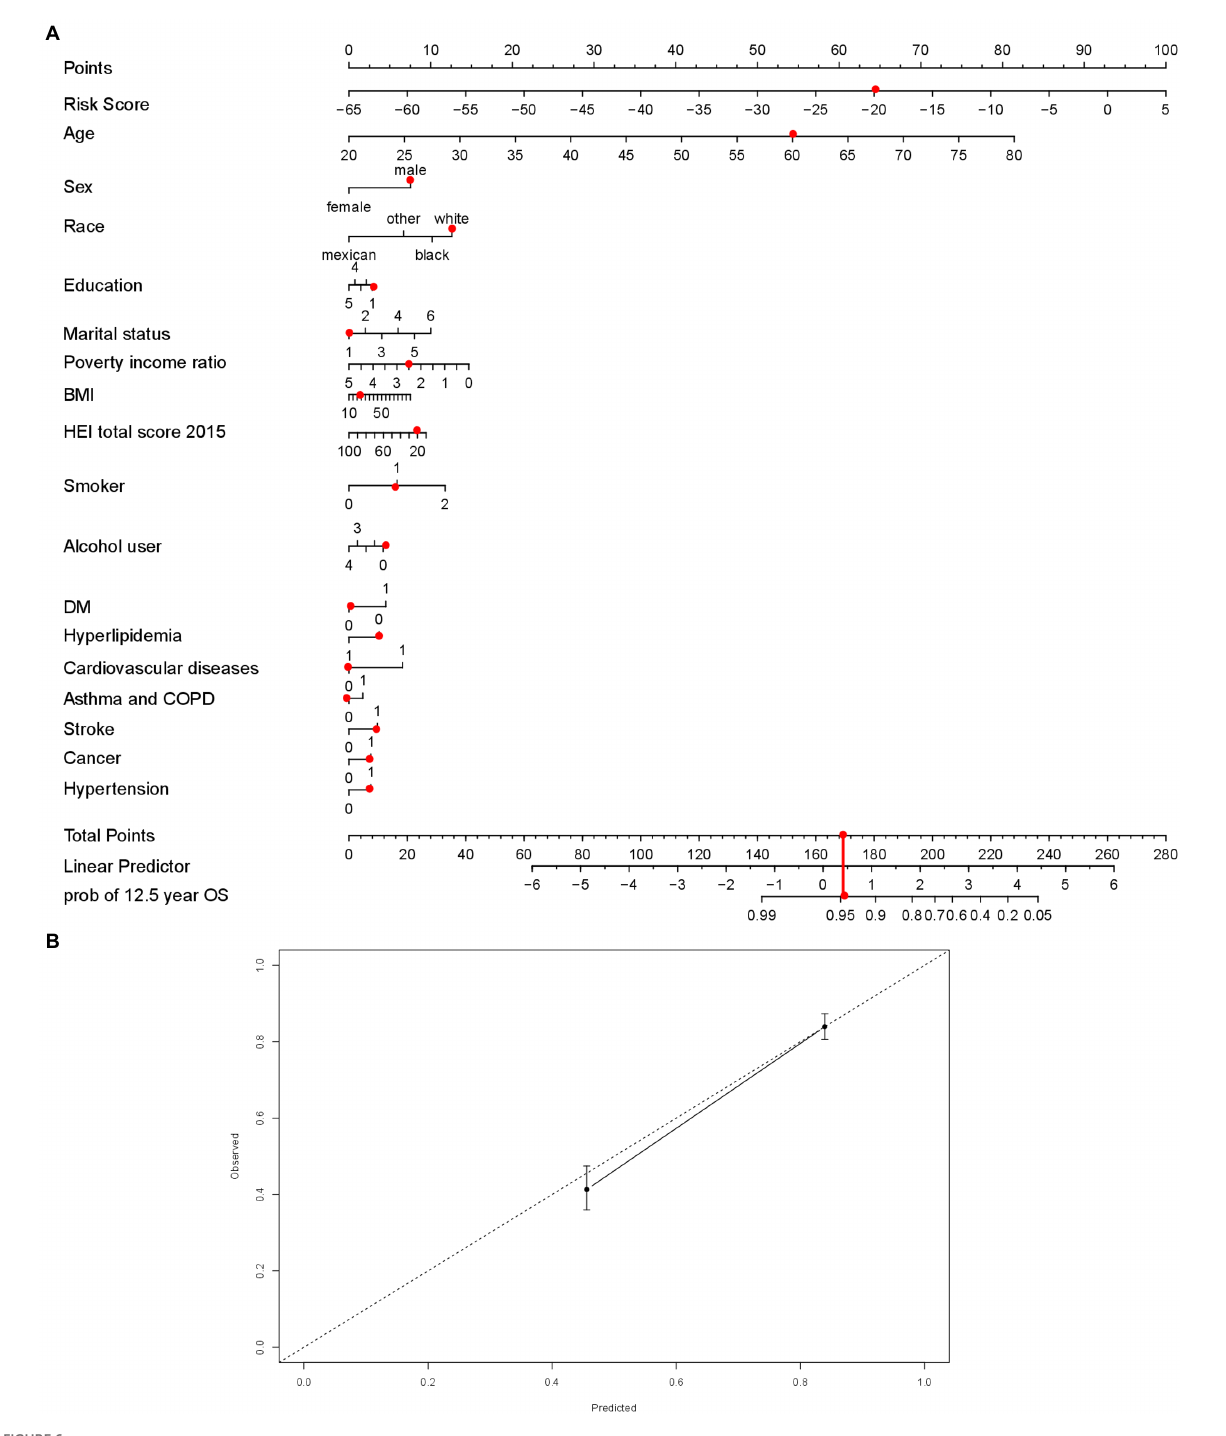
FIGURE 6 The nomogram established with risk score (A) , red dots demonstrated an example with points for each variables, total points and possibility of survival at 12.5 years. Calibration curve to assess the consistency of predicted survival possibility at 12.5 years by the nomogram with risk score. (B) BMI = body mass index; HEI = Healthy Eating Index, 2015 version; Smoking indicated as 0 (non-smokers), 1 (former smokers), and 2 (current smokers); Alcohol use indicated as 0 (non-drinkers), 1 (former drinkers), 2 (mild drinkers), 3 (moderate drinkers), and 4 (heavy drinkers); COPD = chronic obstructive pulmonary disease; DM = type 2 diabetes mellitus. In the disease prevalence, 0 indicates no and 1 indicates yes. In the education, less than 9th grade was coded as 1; 9–11th grade (includes 12th grade with no diploma) as 2; high school graduation or equivalent as 3; some college or associates degree as 4; college graduate or above as 5. For the marital status, married was coded as 1; divorced as 2; separated as 3; never married as 4; widowed as 5; living with partner as